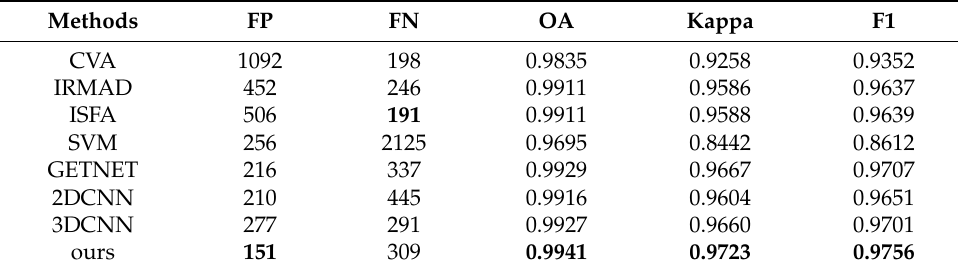
Figure 7. The change map on Umatilla dataset. ( a ) CVA. ( b ) IRMAD. ( c ) ISFA. ( d ) SVM. ( e ) GETNET. ( f ) 2DCNN. ( g ) 3DCNN. ( h ) ours. Table 2. Quantitative evaluation of CD results by different methods for Umatilla